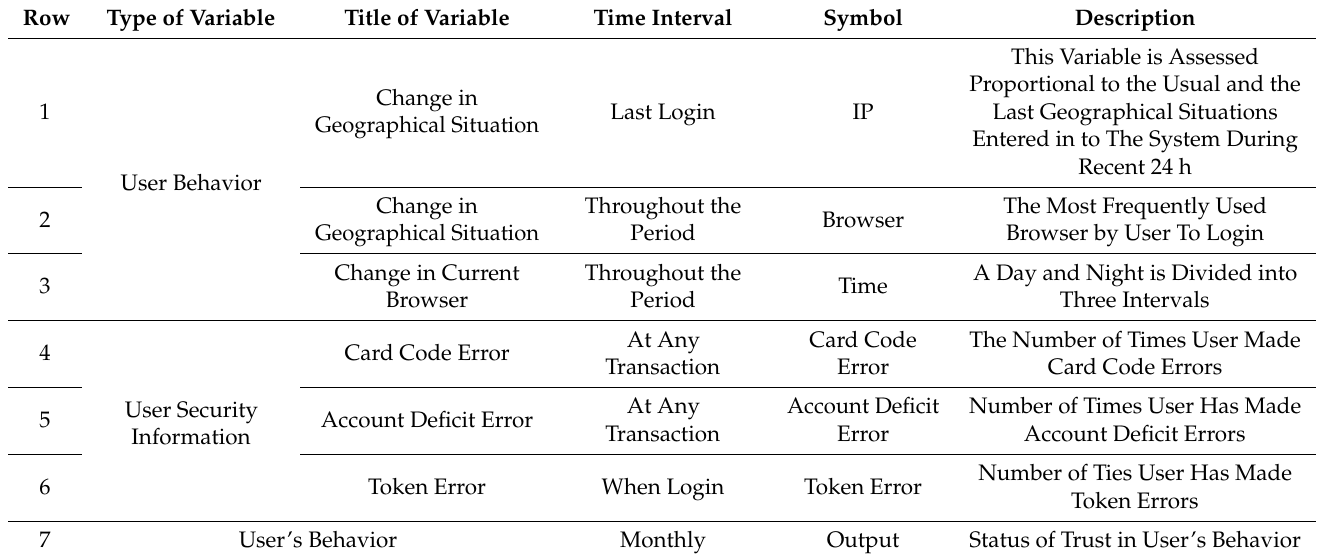
Table 2. Values and intervals of main variables in fuzzy system (source: research